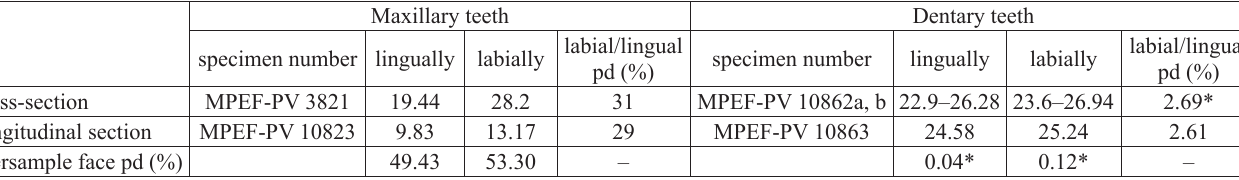
Table 1. Thickness (in μ m) of enamel. Abbreviations: pd, proportional difference of enamel thickness between compared faces; *, average